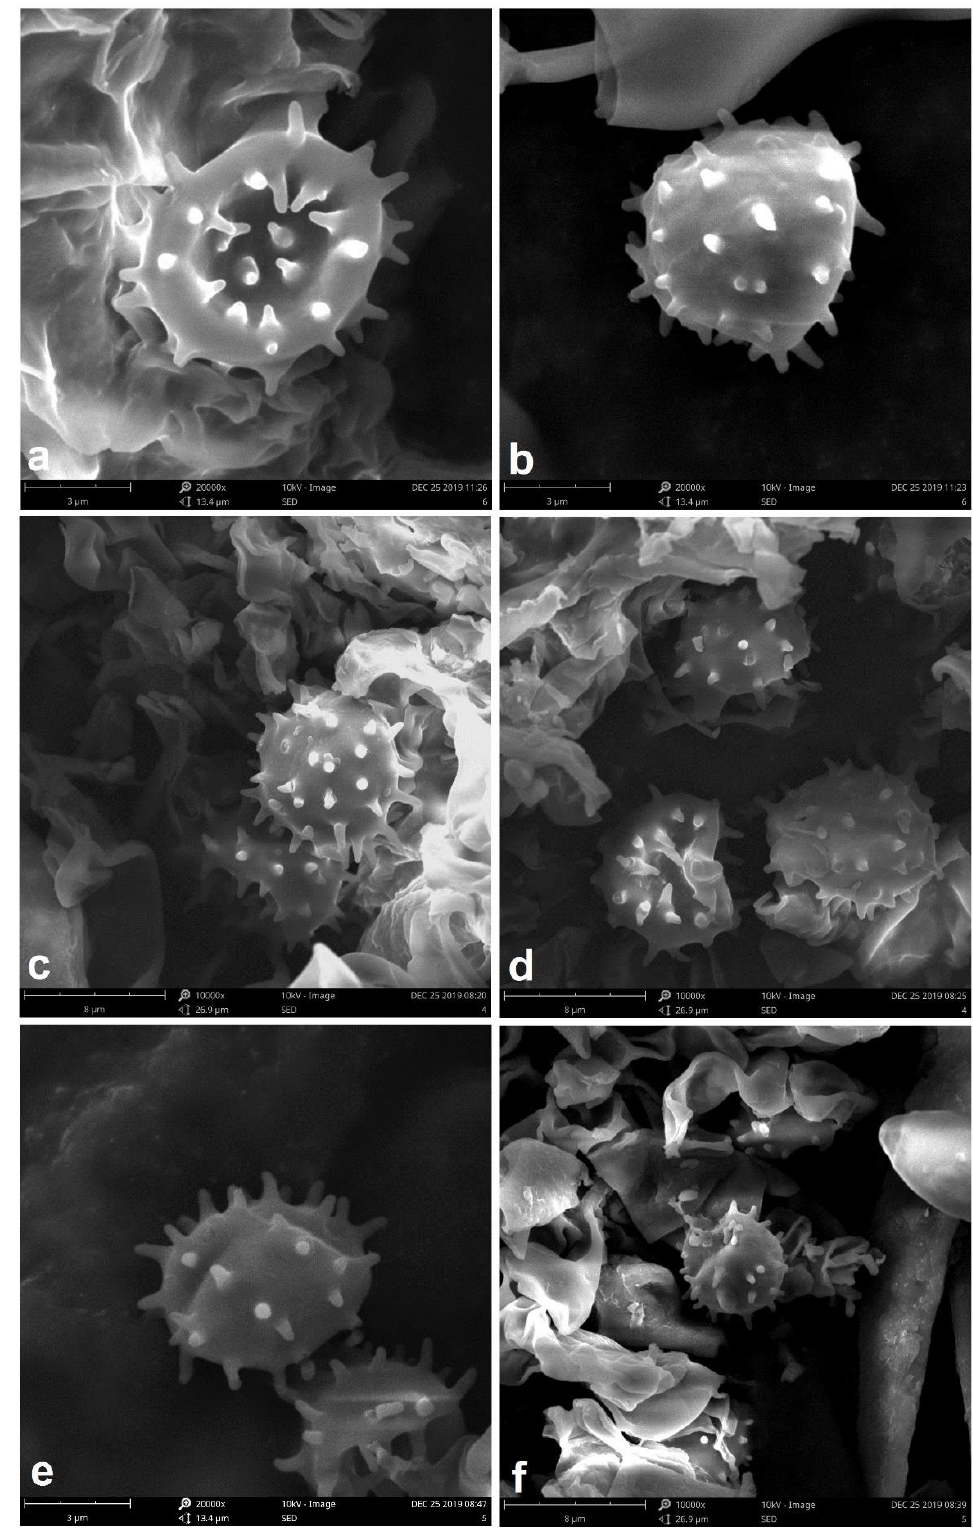
Figure 3. SEM of basidiospores of Tomentella species. ( a,b ) T. aurantispora (holotype Yuan 14268); ( c,d ) T. kanasensis (holotype Yuan 14034); ( e , f ) T. schrenkiana (holotype Yuan 14262).